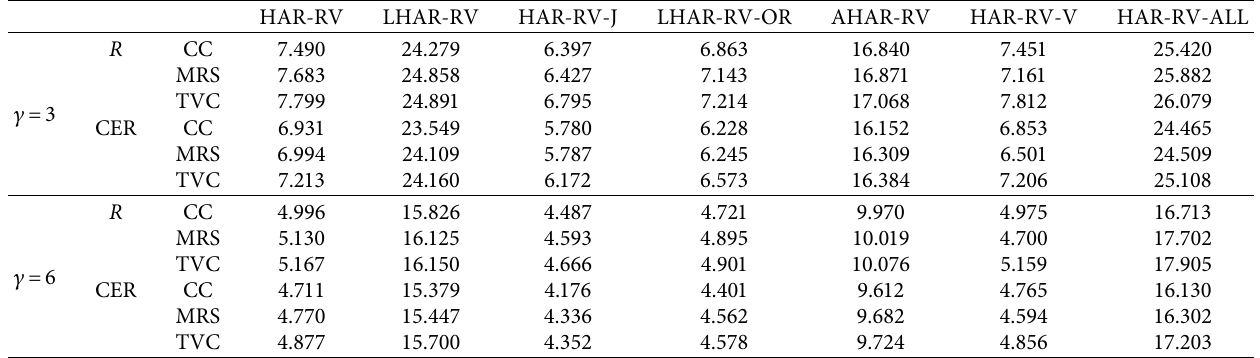
Table 4: Portfolio performance measures, 2006-10-9 to